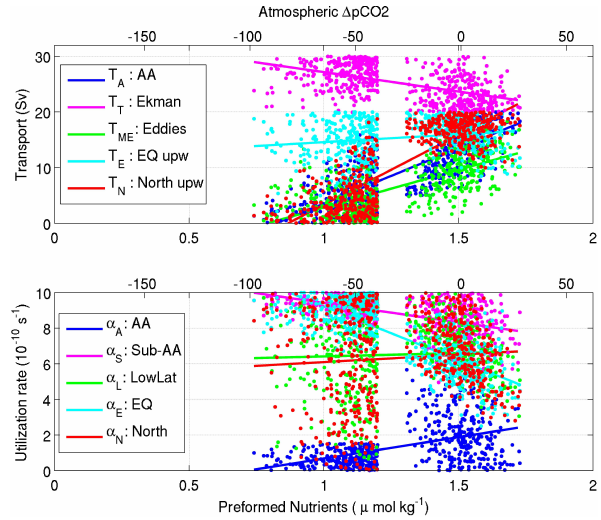
Fig. 8. Same as Fig. 3 but for the division between the upper and deep ocean at 300m instead of the standard